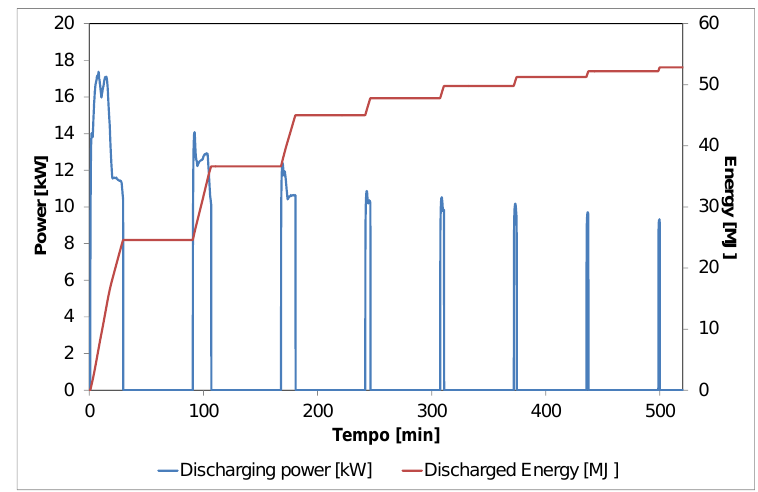
Figure 8. Thermal power and energy discharged by the hybrid TES system during Test B.